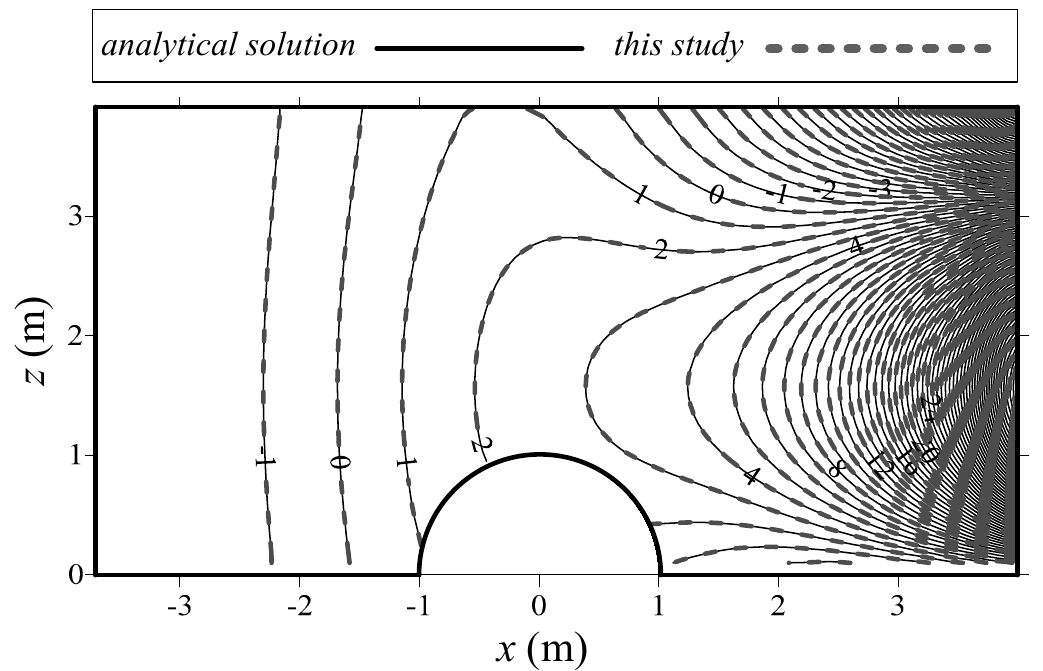
Figure 10. Comparison of head distribution of the method of fundamental solutions (MFS) with the analytical solution on profile y = 0.5.